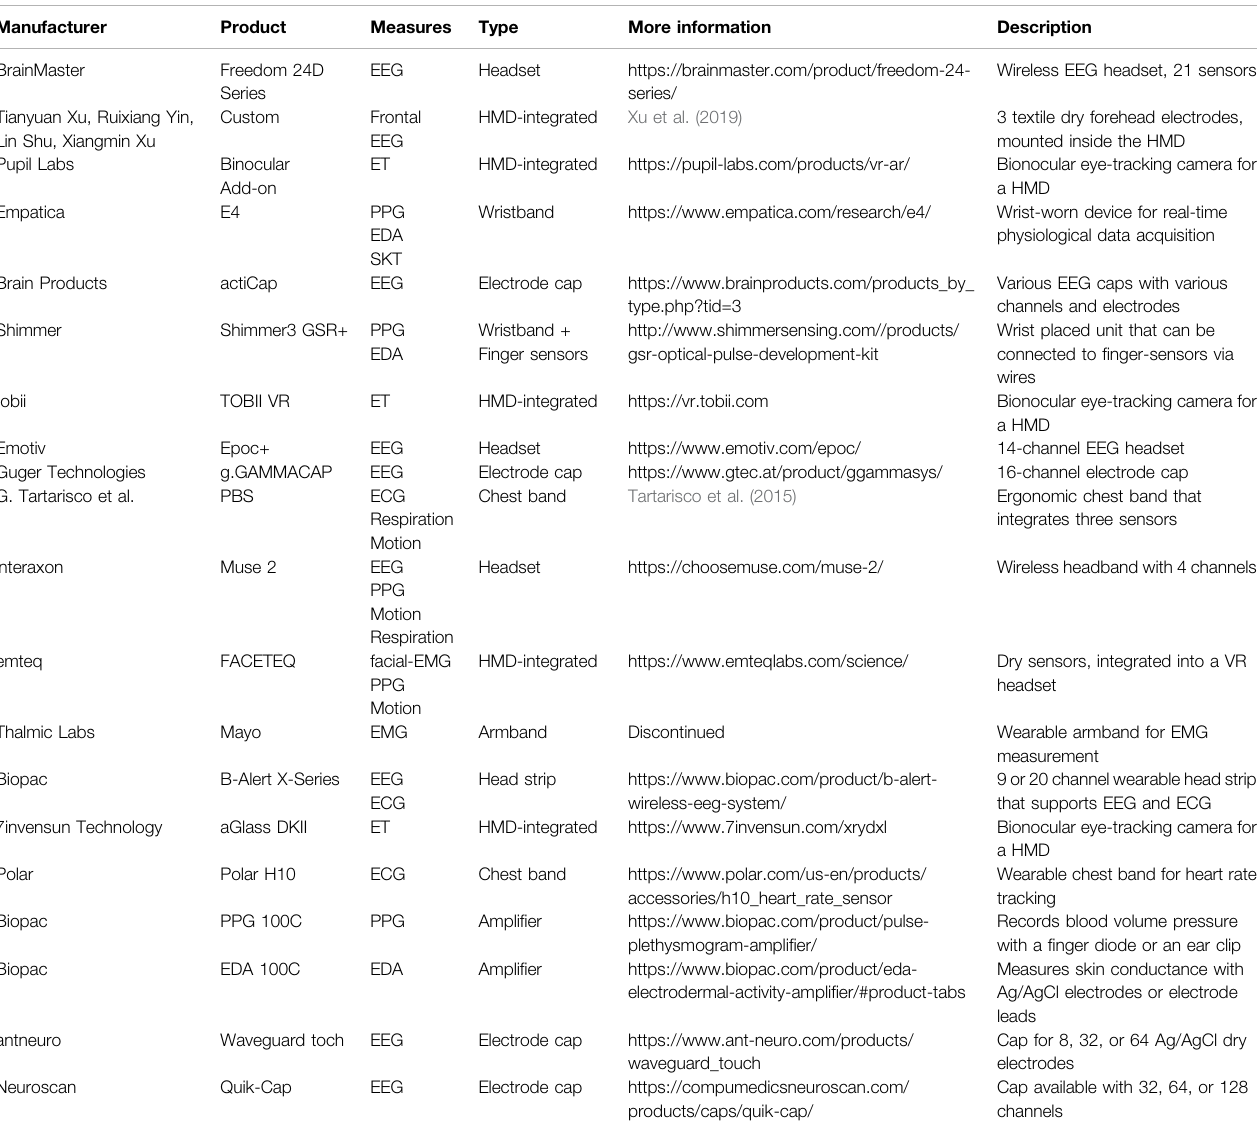
TABLE 3 | Sensors used in the identi fi ed classi fi cation approaches.